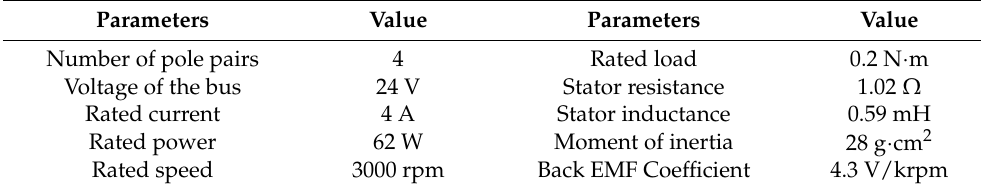
Figure 7. The simulation model of RLS-DSVM-MPC. Table 2. PMSM parameters in the